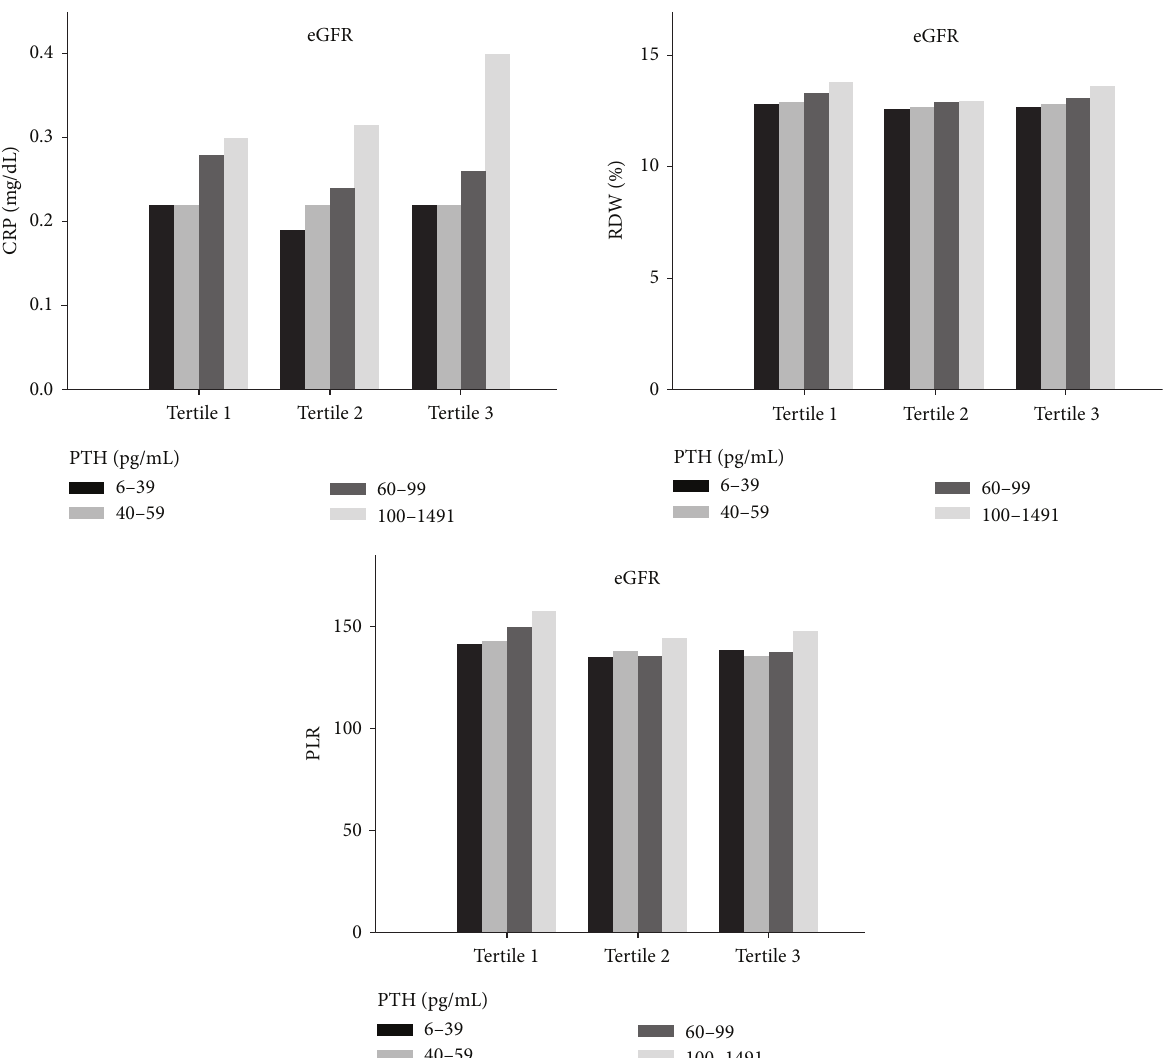
Figure 1: Unadjusted estimated glomerular filtration rate- (eGFR-) stratified levels of C-reactive protein (CRP), red blood cell distribution width (RDW), and platelet-to-lymphocyte ratio (PLR) by parathyroid hormone (PTH)